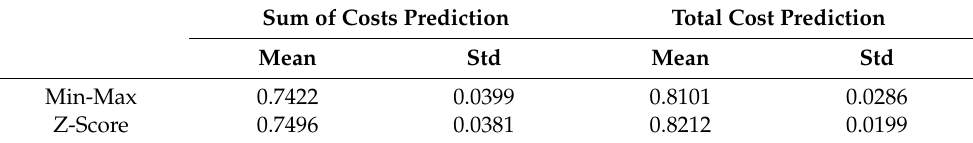
Table 6. R-square score of cases.